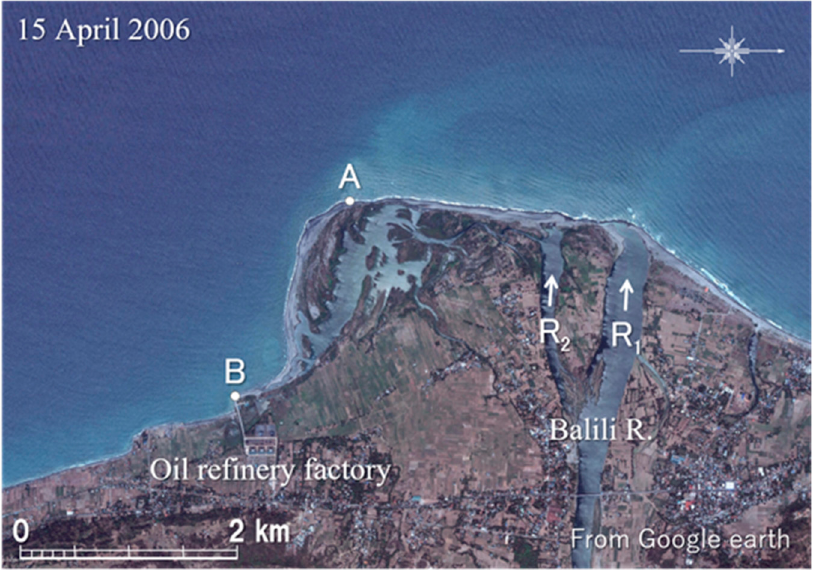
Figure 3. Satellite image of shoreline around Balili River mouth (15 April 2006).